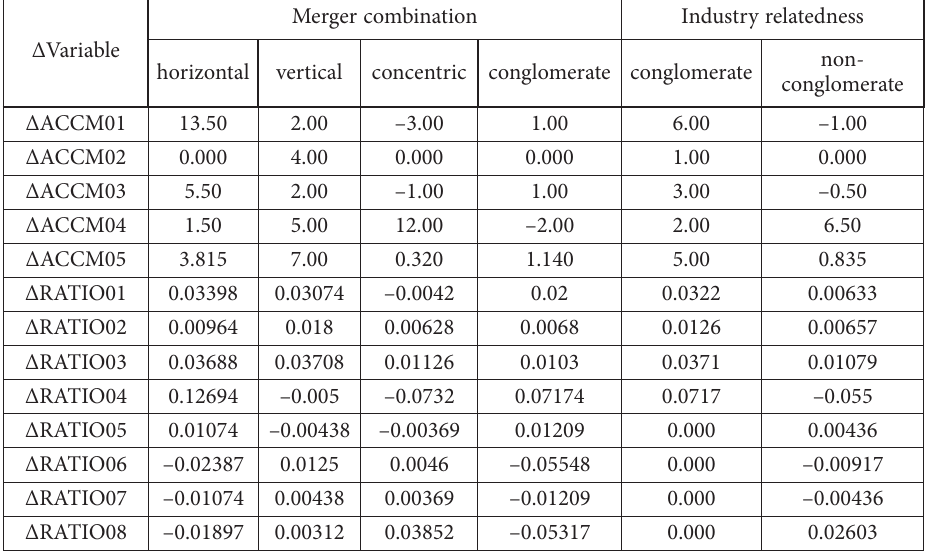
Table 7. Results from merger combination and industry relatedness Merger combination Industry ΔVariable